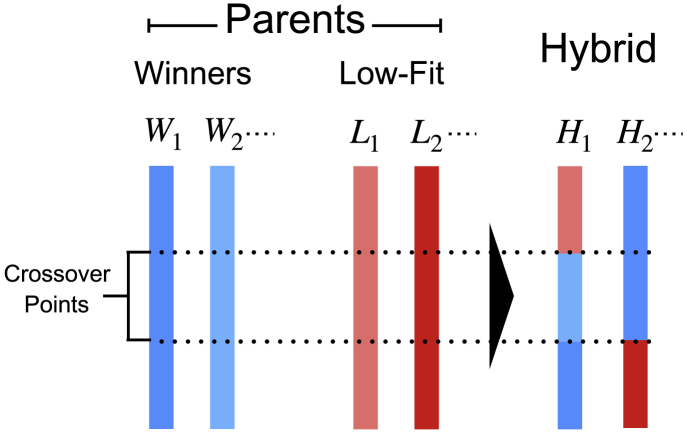
Schematic representation of the crossover operation generating the hybrid force-fields. The color bars indicate the sets of kang coefficients associated to the winners and the low-fit force-fields. These are mixed randomly in the hybrid force-fields. To see this figure in color, go online.